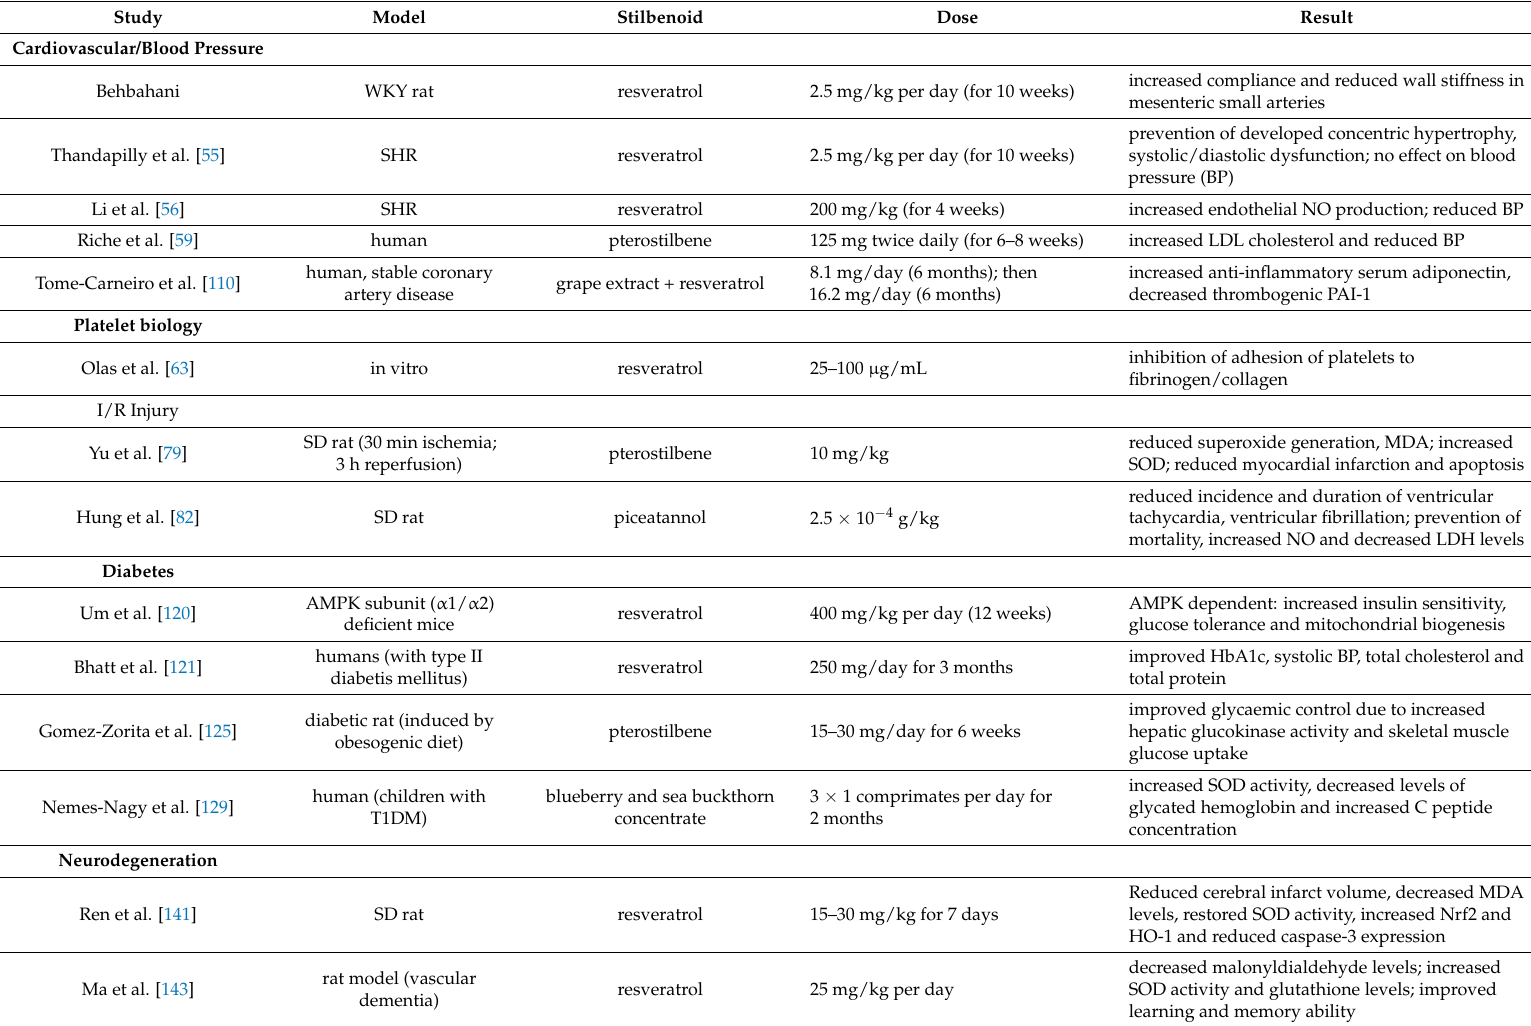
Table 2. Summary of biological effects of